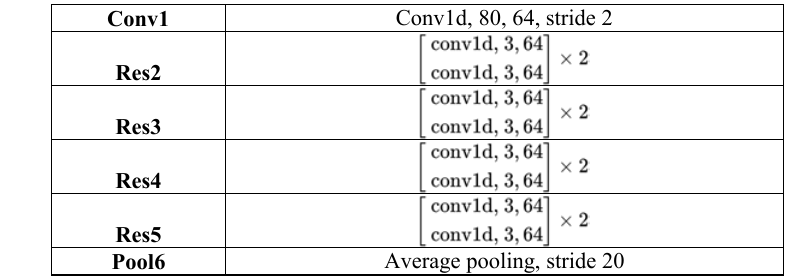
Table 1. The architecture of Front-end.